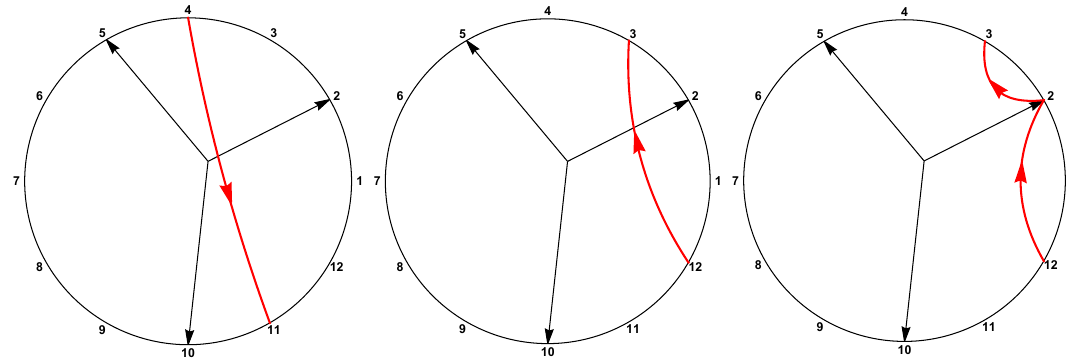
Figure 3 . The boundary of the disk is always oriented counter-clockwise. To determine the relations among planar poles imposed by split kinematics, draw any directed arc ( a → c ) and homotope the arc until it is near the parallel counter-clockwise oriented boundary of the disk. If the arc has to cross exactly one leg of the tripod, say b with a < b < c cyclically, then the planar pole decomposes as s a,a +1 ,...,c = s a,a +1 ,...,b + s b,b +1 ,...,c . Above, due to momentum conservation, we have the relation s a,a +1 ,...,b = s b +1 ,b +2 ,...,a − 1 , noting that the directed arc correspondingly switches orientation in going from the left to the center diagrams. Applying the homotopy to the parallel boundary of the disk gives that s 4 , 5 ,..., 11 = s 12 , 1 , 2 , 3 = s 12 , 1 , 2 + s 2 , 3 .